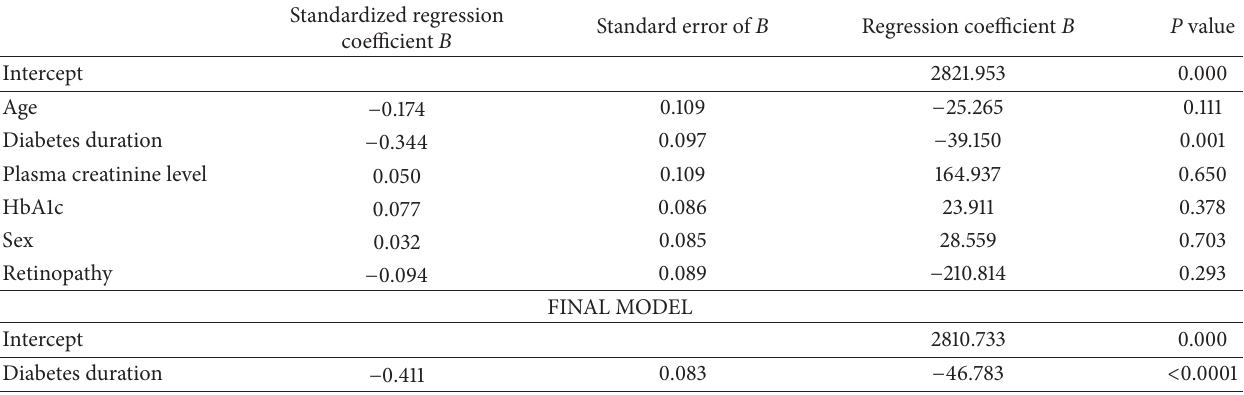
Table 2: Multiple regression analysis for ECD.